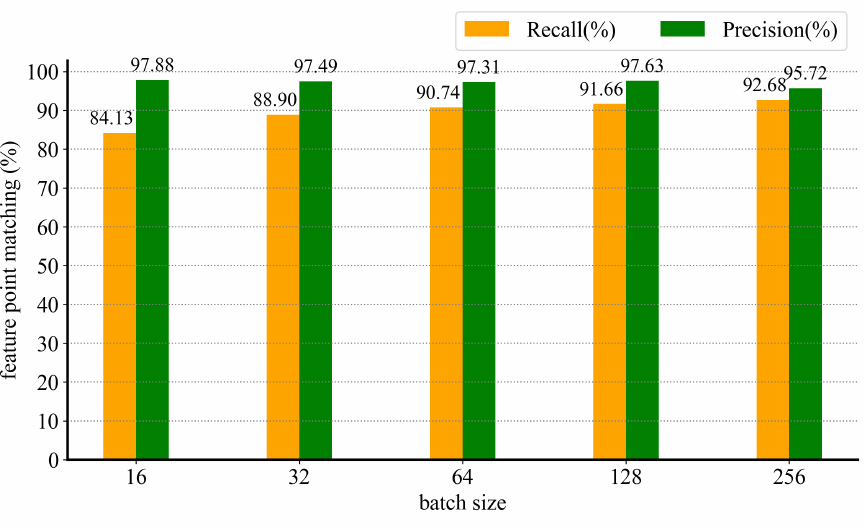
Figure 6. Feature point matching effect versus batch size on BundleFusion